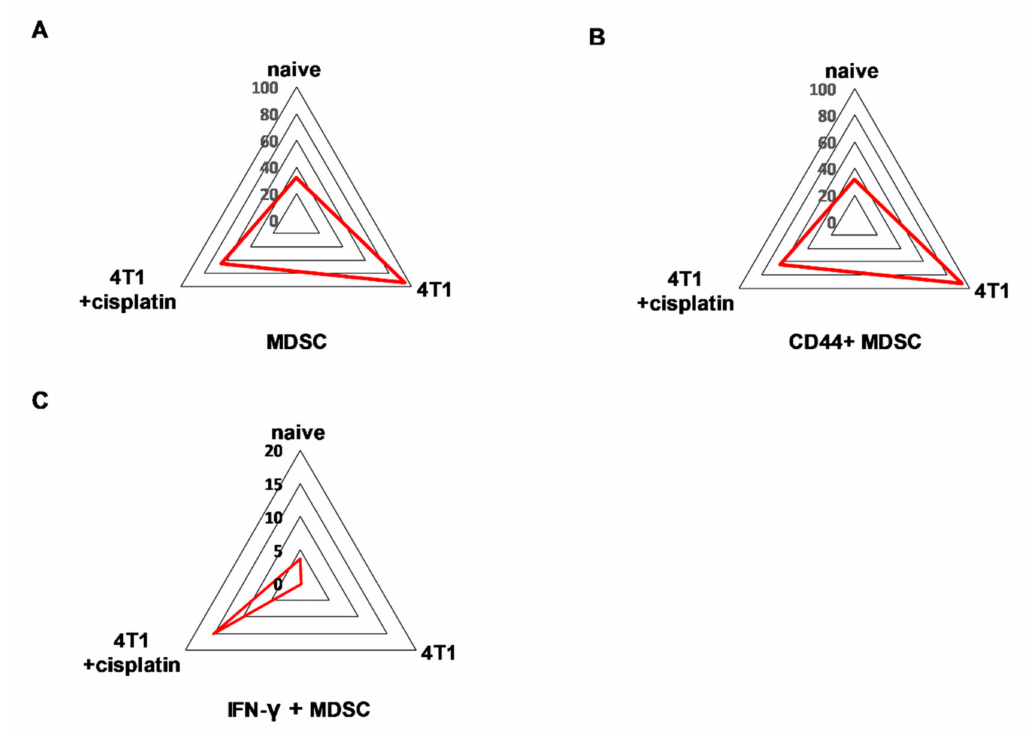
Figure 9. The trajectories on the radar plots delineate the characteristic marker profile of blood-derived leukocytes in naive, 4T1 tumor bearing, and cisplatin treated tumorous mice. The accumulation of peripheral ( A ) CD11b +/ Gr-1 + MDSCs and ( B ) CD44 + MDSCs is a characteristic of 4T1 breast cancer. ( C ) Due to cisplatin treatment IFN- γ + MDSCs were developed at the periphery. The percentage of the given populations is demonstrated on the radar plots within the CD45 + living singlets determined by manual gating in Cytobank. The gating hierarchy is explained in the text. The markers of the panel which were not detected or did not show di ff erential expression are not shown. Representative radar plots are shown from the pooled samples of 6 mice per group as described in Section